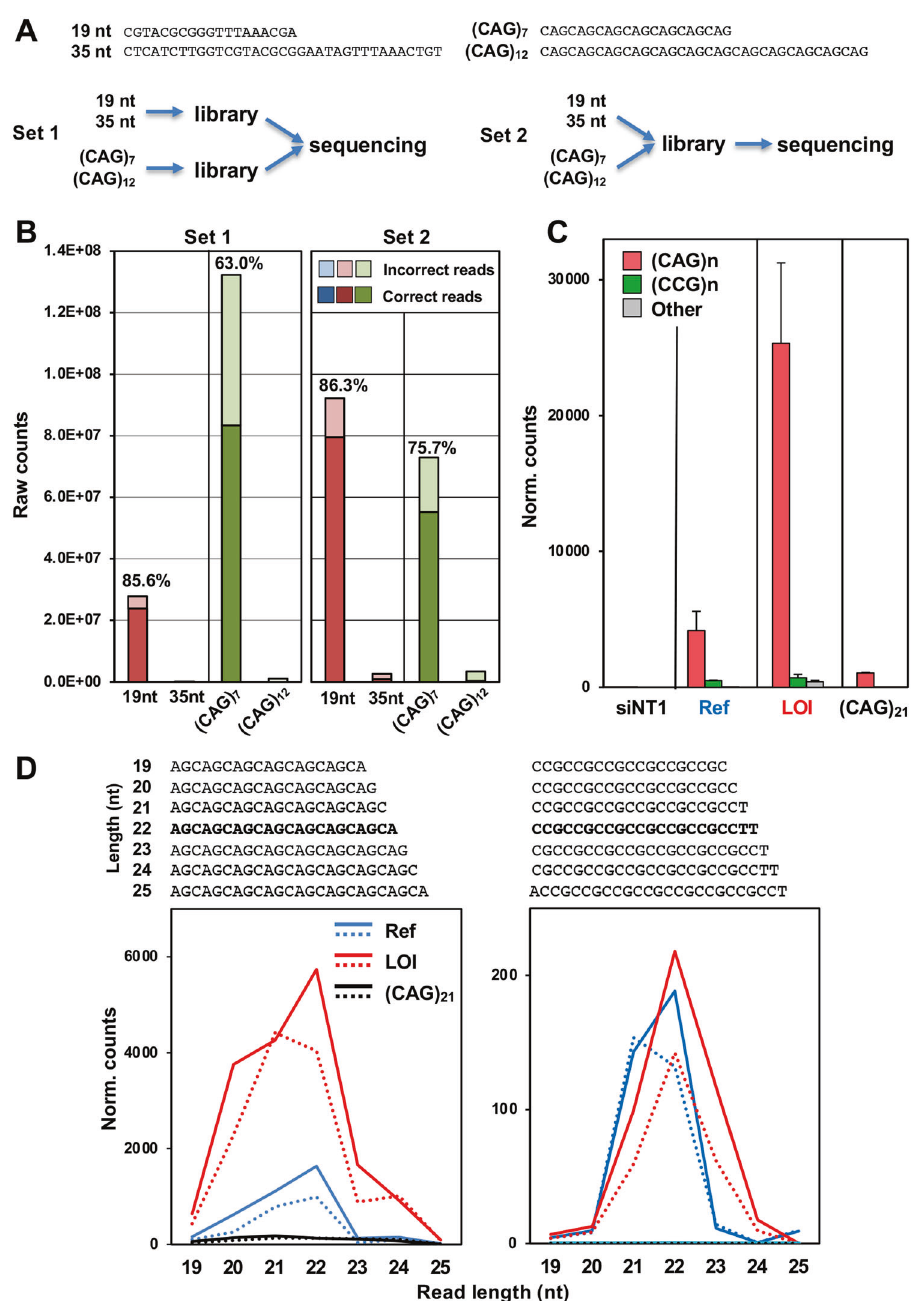
Fig. 5 The LOI mutant HP results in a higher number of toxic sCAGs in the RISC of transfected cells than the Ref HP. A Top , the four sequences that were converted to libraries and sequenced by small RNA seq; bottom , schematics explaining two different sequencing approaches. For set 1 two libraries were prepared, one containing a 1:1 mixture of 10 pmol of size markers (19 and 35 nts long) and another containing a 1:1 mixture of 10 pmol of two CAG repeat containing RNAs (21 and 36 nt) and then together subjected to smRNA seq on an lllumina HiSeq 3000. For set 2 the four oligonucleotides were mixed 1:1:1:1 and the resulting library was subjected to sequencing. B Raw counts of the two libraries. Percent of reads that had the exact length and sequence of the RNA that was used are indicated. C Normalized read counts detected bound to the RISC in cells transfected with either 2.5 nM siNT1, (CAG) 21 , the Ref HP, or the LOI HP after 24 h (all as shown in C ). Reads that contain only CAG TNR, CCG TNRs or other sequences are shown. Shown are the averages and the variance between the duplicate samples. D Sequences (top) and length distribution (bottom) of HP derived reads detected in the RISC of transfected cells in D . Solid and stippled lines of the same color represent the two